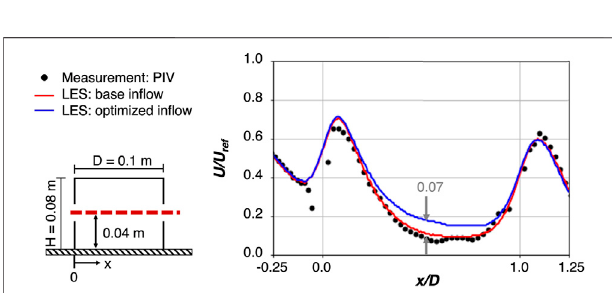
FIGURE 10 | Non-dimensional velocity pro fi le along the center line predicted using the base and optimized in fl ow conditions.